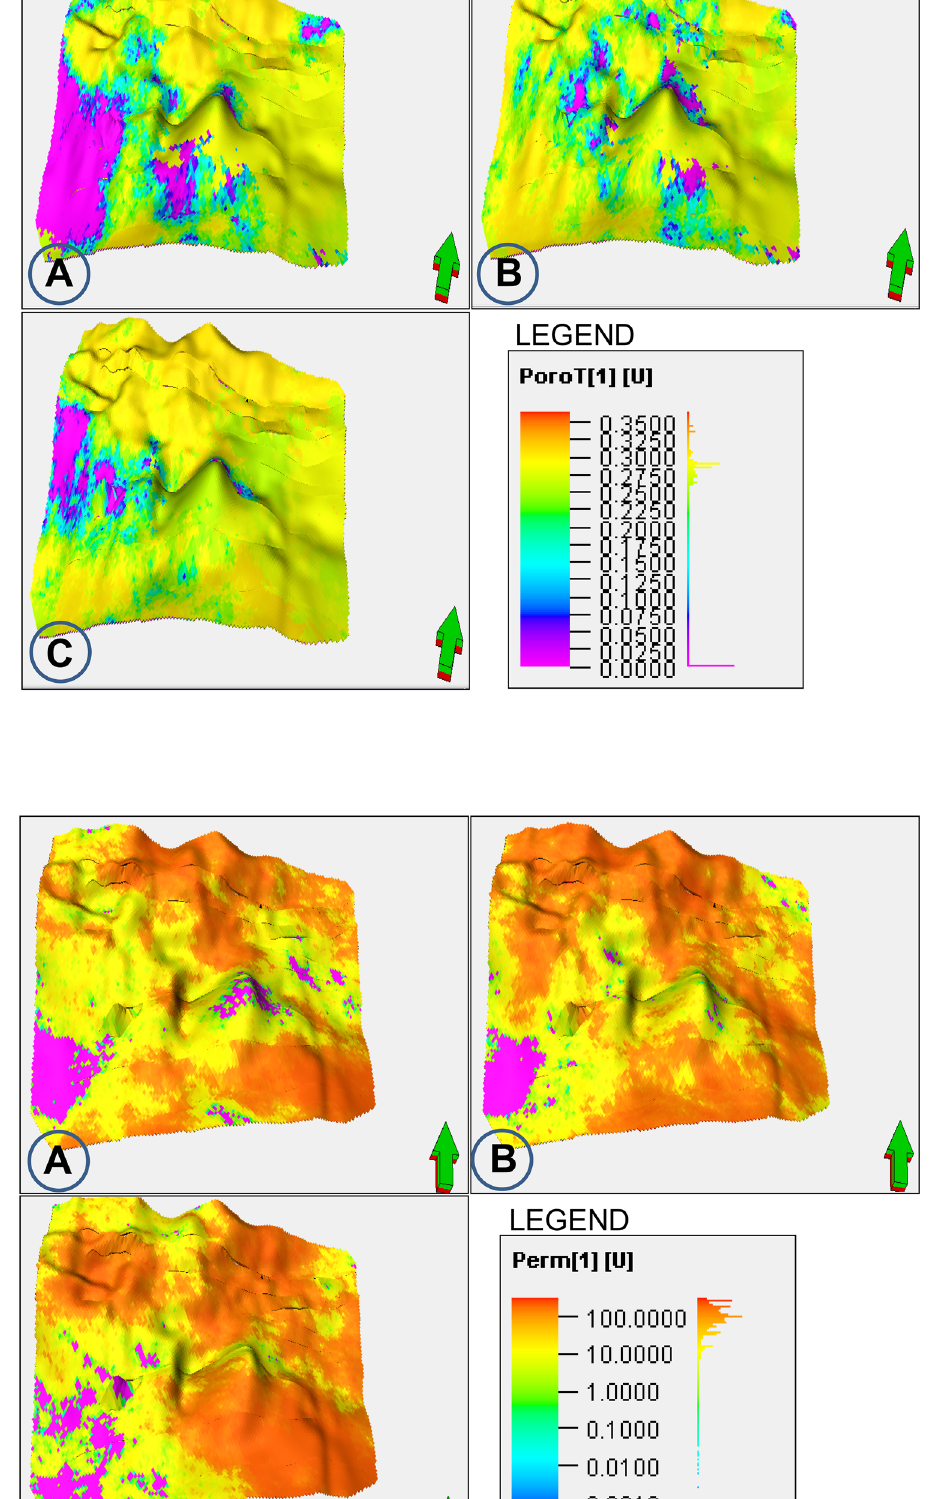
Fig. 14 Equiprobable realiza- tions of total porosity from K300 reservoir